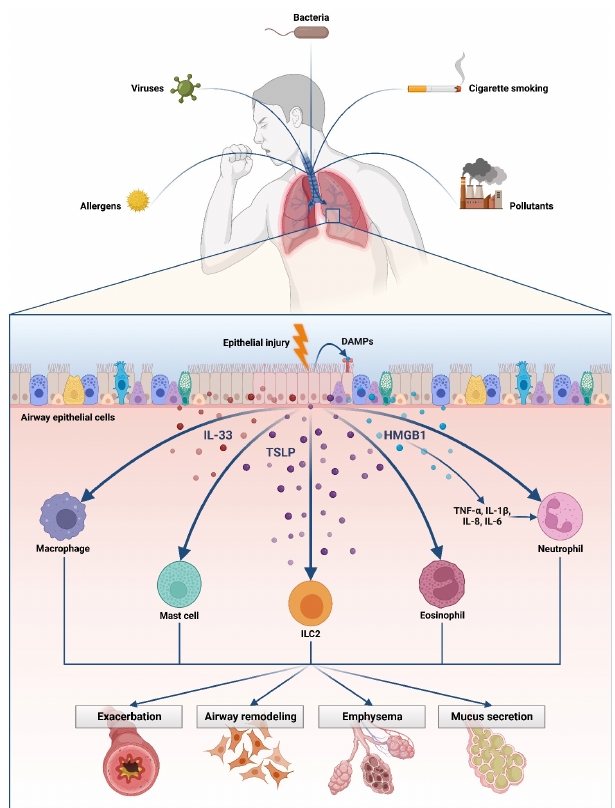
Figure 1. Description of molecular implications of airway epithelial cell alarmins in the pathogenesis of chronic inflammatory lung diseases, in particular in the pathogenetic mechanism that induces exacerbations, airway remodeling, emphysema, and mucus secretion.